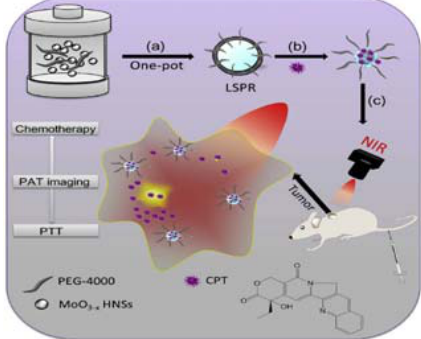
Figure 6. Schematic illustration of ( a , b ) the synthesis process of CPT loaded PEG ‐ MoO 3 − x HNSs nanovehicle for ( c ) PAT imaging ‐ guided combinational chemo ‐ photothermal therapy of cancer. nanovehicle for ( c ) PAT imaging-guided combinational chemo-photothermal therapy of cancer. Reprinted from Biomaterials, Vol. 76, Bao et al. [106], pp. 11–24, Copyright (2015), with permission Reproduced with permission from [106]. Elsevier, from Elsevier.